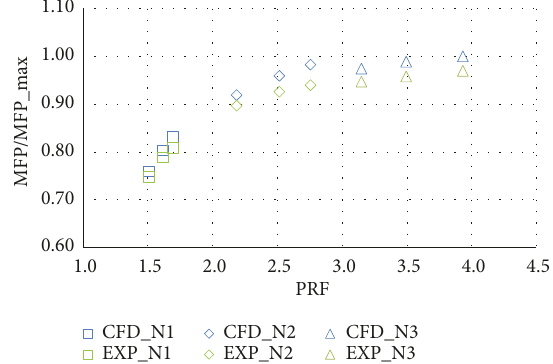
Figure 7: MFP (referred to maximum value) vs PRF in partial shroud admission, CFD (blue) and experimental data (green). Table 6: Percentage difference for MFP values.